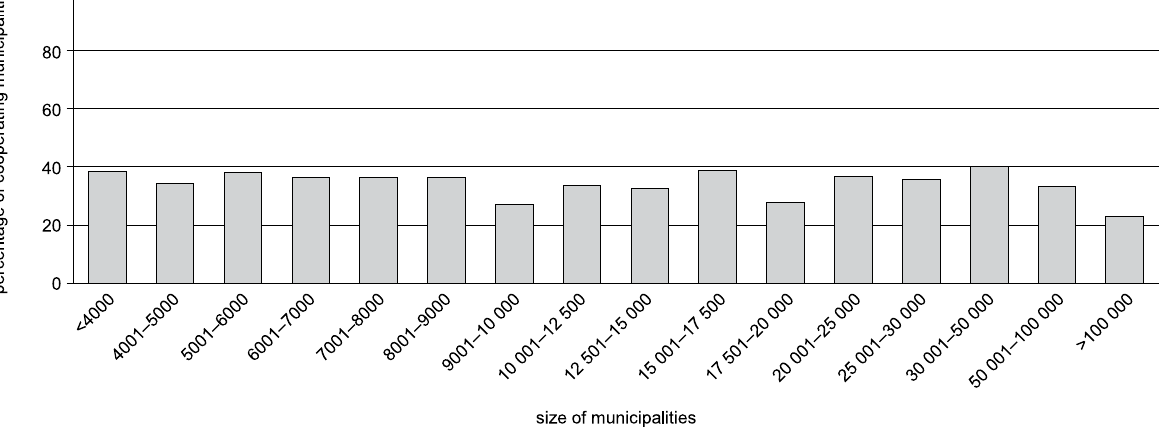
Fig. 4. Membership of inter-municipal bodies engaged in municipal waste management versus the size of municipalities. Source: own